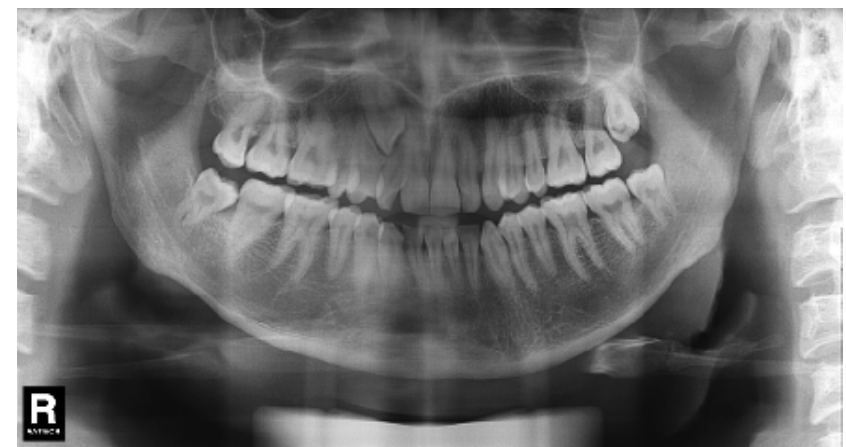
Figure 1: Panoramic Image Showing Unilateral Impacted Maxillary